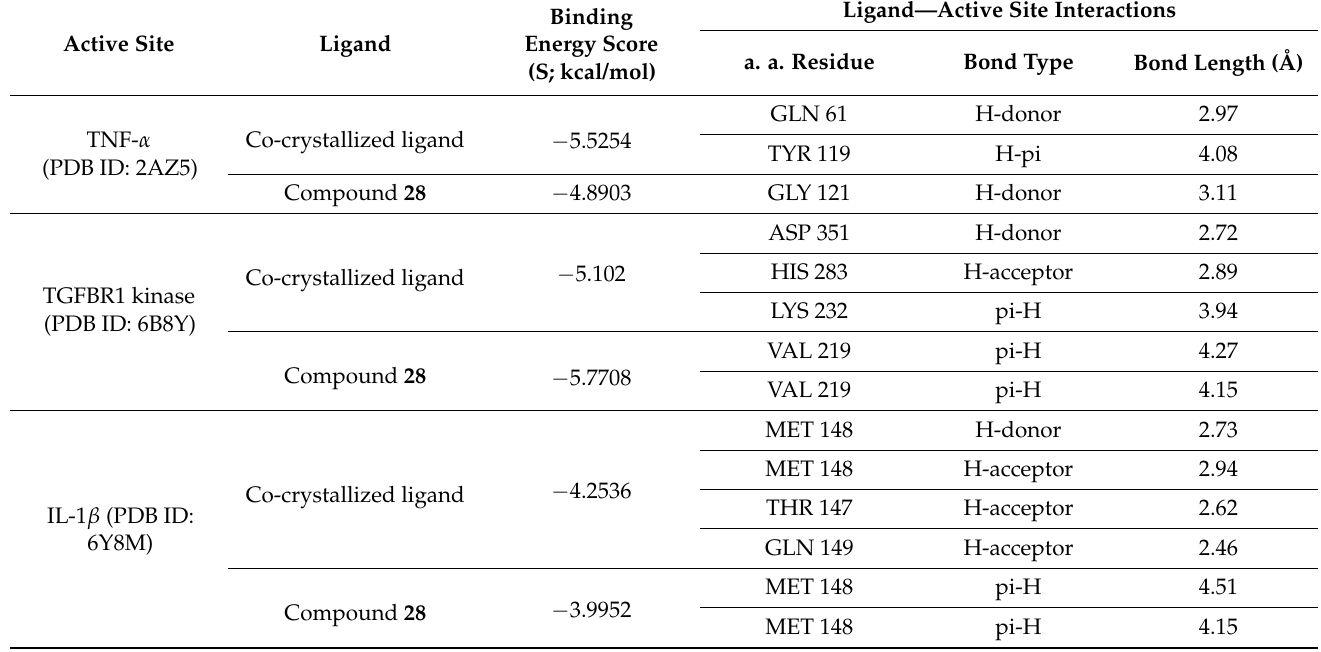
Table 6. Binding free energy score (S; kcal/mol) with binding interactions for different co-crystallized ligands and compound 28 within TNF- α (PDB ID: 2AZ5); TGFBR1 kinase (PDB ID: 6B8Y); and IL-1 β (PDB ID: 6Y8M) binding